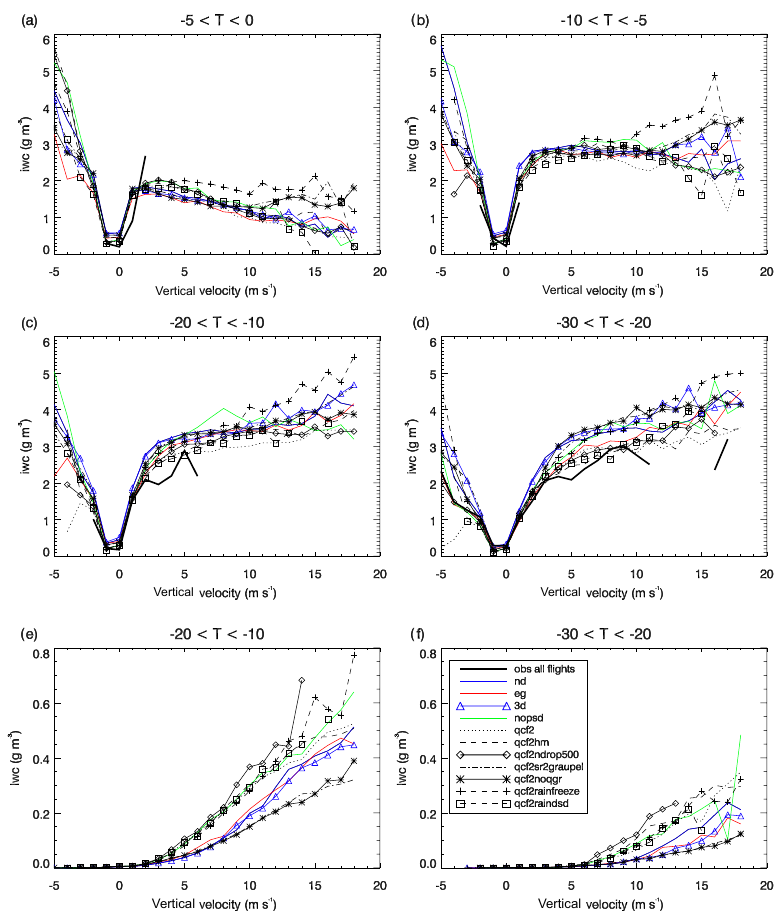
Figure 12. Ice water content (gm − 3 ) as a function of vertical velocity (m s − 1 ) for four temperature regimes: (a) − 5 to 0, (b) − 10 to − 5, (c) − 20 to − 10 and (d) − 30 to − 20 ◦ C. Panels (e, f) show liquid water content (gm − 3 ) as a function of vertical velocity for the two coldest regimes: (e) − 20 to − 10 and (f) − 30 to − 20 ◦